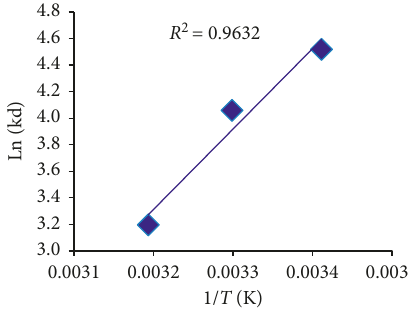
Figure 11: Effect of temperature on the distribution constant of the adsorption phenomenon.